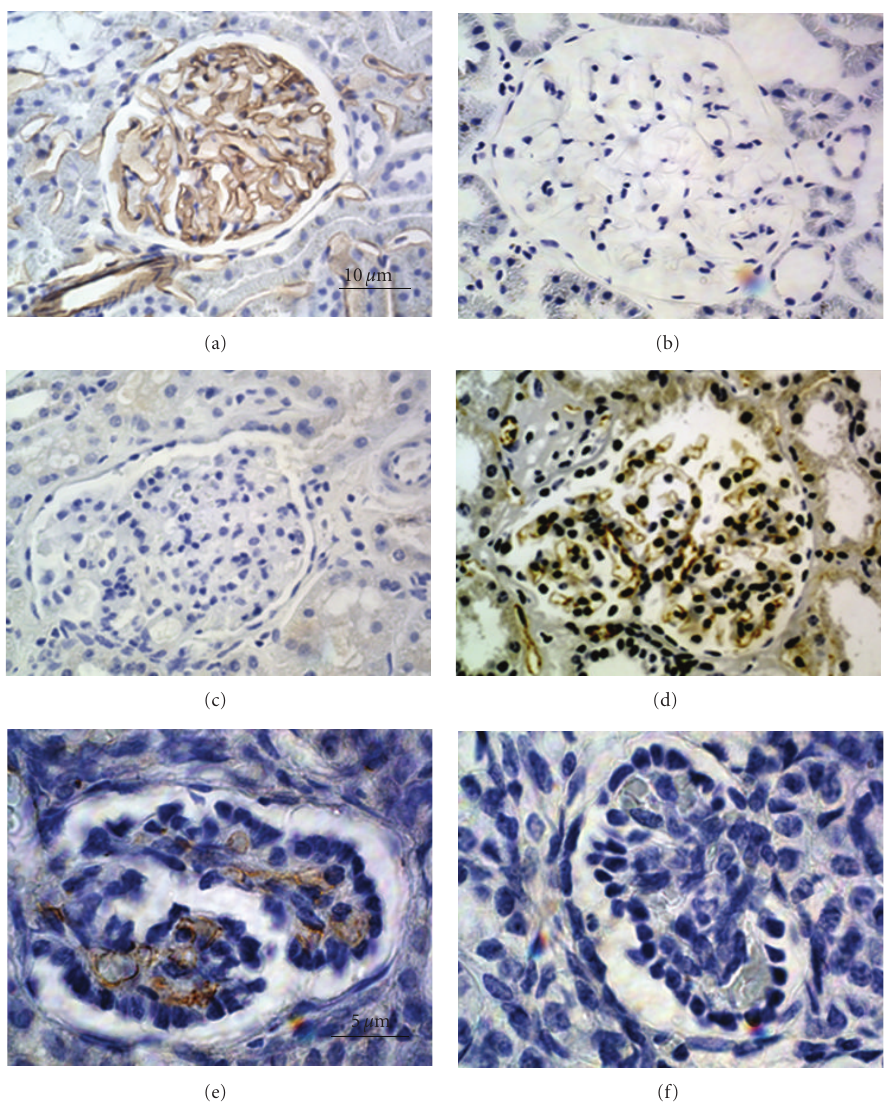
Figure 2: Photomicrographs of stained sections of (a, c) rat kidney; (b, d) pig kidney; (e, f) a pig renal primordium from an E28 embryo 8 weeks after transplantation into a rat mesentery, stained with RECA-1 (a, b, e) or CD31 (c, d, f). Glomerular capillaries in transplants stain positive for RECA-1 that is specific for rat endothelium (e) and negative for CD31 that is specific for pig endothelium (f). Magnifications are shown for (a–d) (in (a)) and (e) and (f) (in (e)), reproduced with permission